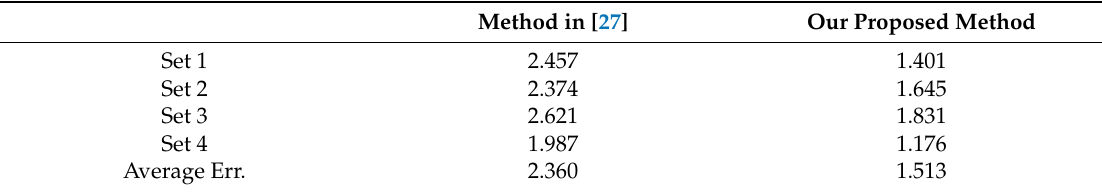
Table 2. Comparisons of rectification errors for 4 rectified stereo image pairs (in